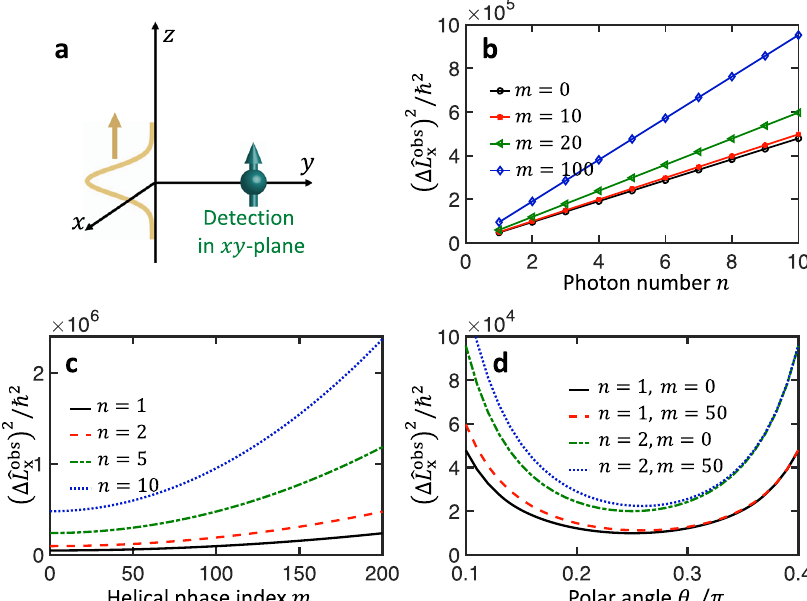
Fig. 3 Photonic orbital angular momentum (OAM) fl uctuation in the transverse plane. a OAM measurements in the direction orthogonal to the propagating z -axis. A Bessel pulse has vanishing mean OAM in xy -plane but non-zero OAM fl uctuations, ð Δ ^ L obs x Þ uncertainty of ^ L obs x is linearly proportional to the photon number n in the pulse. Different lines correspond to different helical phase index m . c The quantum uncertainty of ^ L obs x is proportional to the square of m . d The OAM fl uctuation in xy -plane is strongly dependent on the polar angle θ c of a Bessel pulse. The ratio C 0 has been taken as 100 in all simulations.